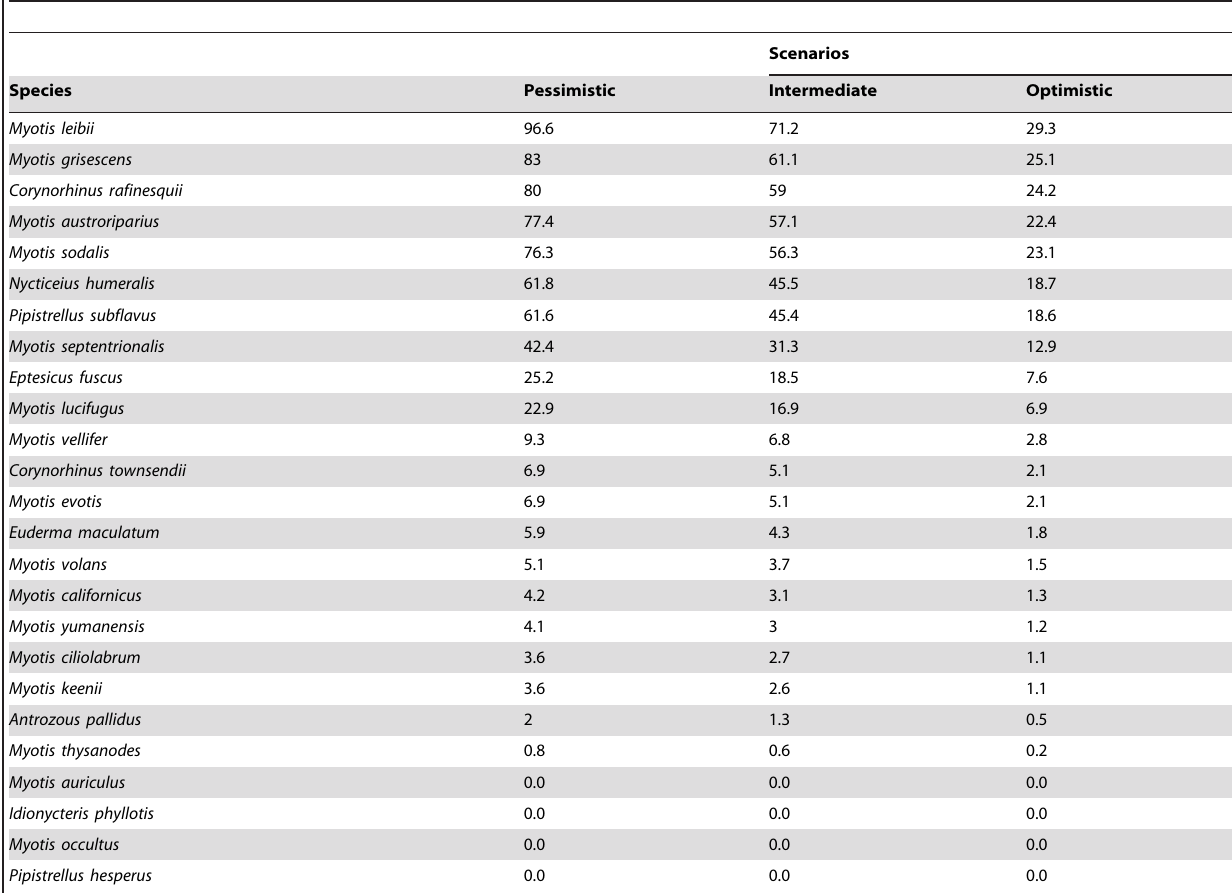
Table 1. The expected relative population reduction of the North American bats susceptible to the White-Nose syndrome spread according to three population-reduction